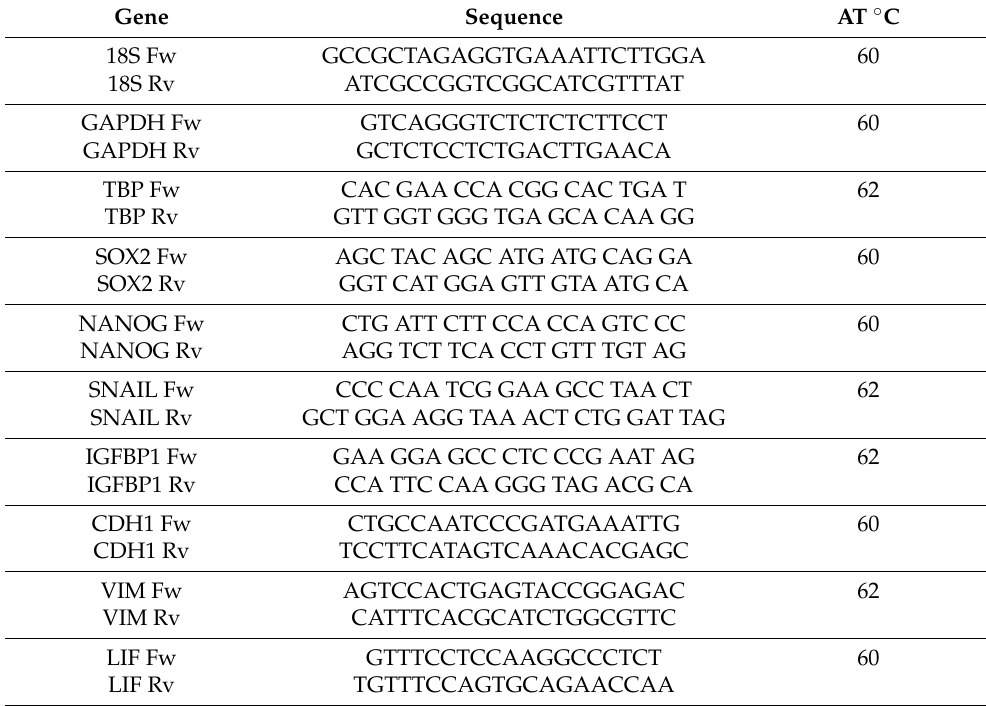
Table 2. Primer sequence and annealing temperatures (AT) for qRT-PCR.